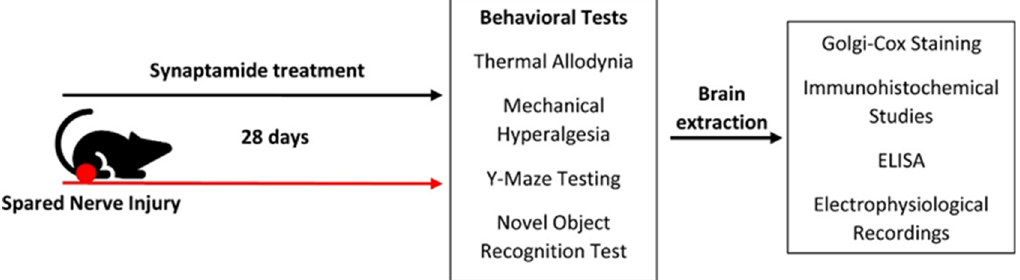
Figure 8. Experimental design. The thermal allodynia and mechanical hyperalgesia were measured weekly for two consecutive days. Memory tests were performed at days 27 and 28 after the surgery. Extraction of the brain for subsequent histological, immunohistochemical, biochemical, and electrophysiological studies was carried out on the 29th day after the surgery.